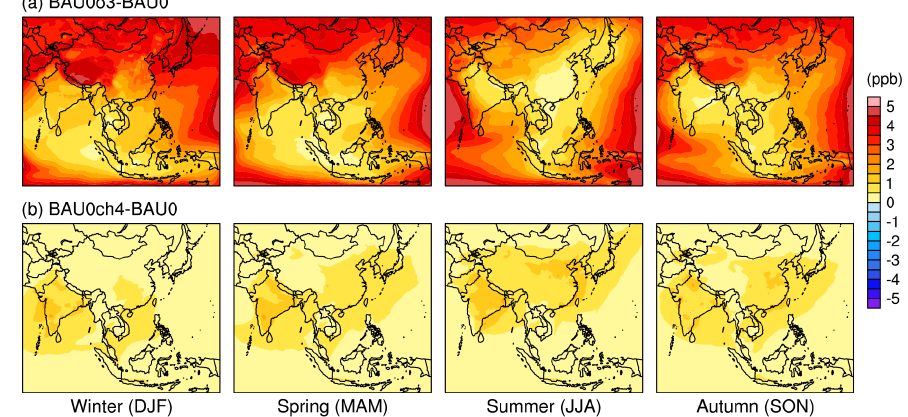
Figure 10. Horizontal distributions of differences in simulated seasonal mean surface ozone concentrations between (a) BAU0o3 and BAU0, and (b) BAU0ch4 and BAU0.